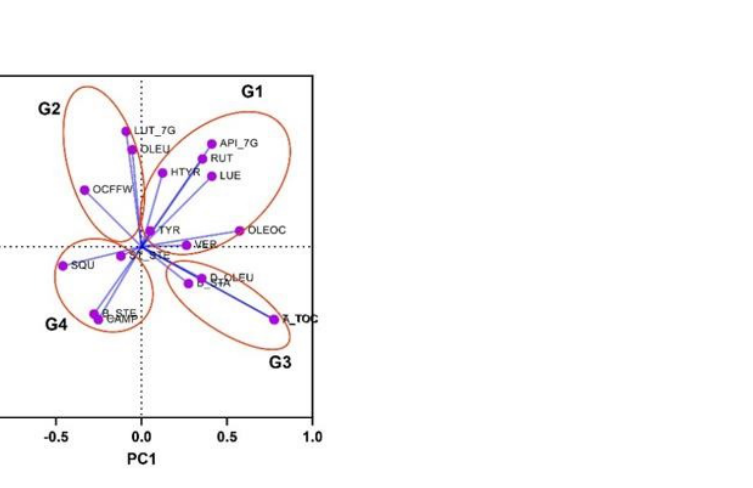
Figure 6. PCA ( A ) and loading plot ( B ) representing the distribution of the cultivars based on the 19 traits in two consecutive crop seasons. G1, cultivars rich in seven analyzed phenols and low in sterols; G2, cultivars rich in two phenolic compounds and OCFFW; G3, cultivars rich in tocopherols, one phenolic compound, and one sterol; and G4, cultivars rich in squalene and sterols.